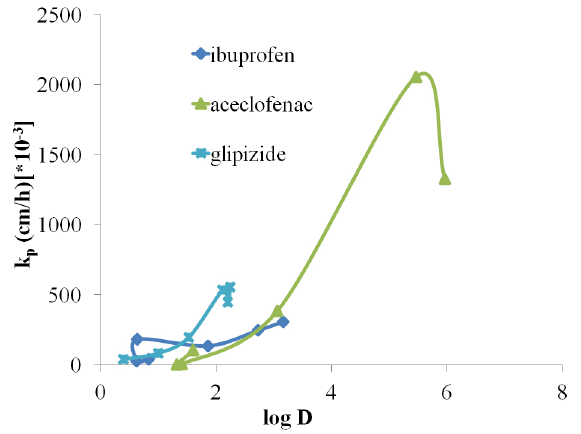
FIGURE 1 - log D vs. Kp of weakly acidic